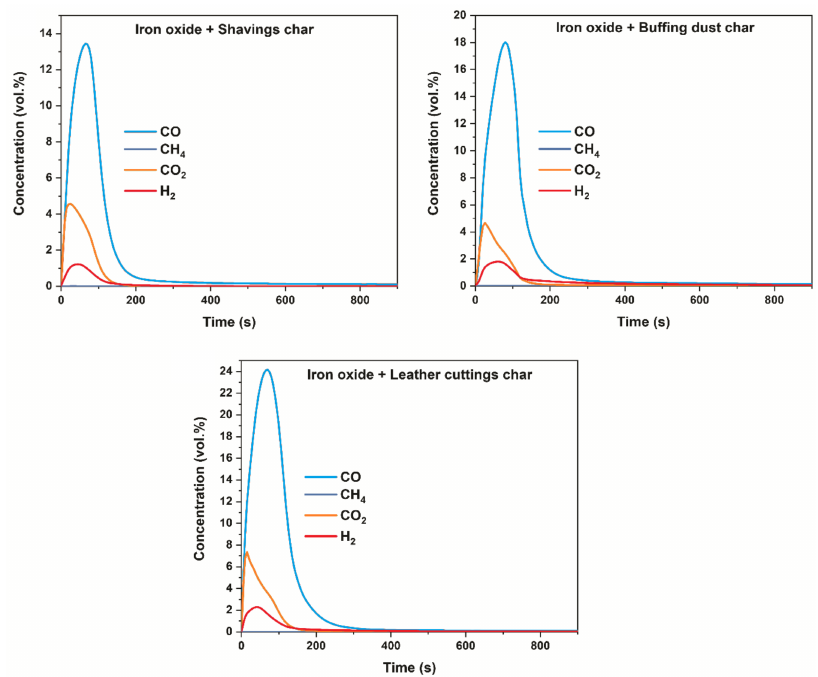
Figure 10. Off-gas produced during the reduction experiments using char produced from leather wastes (Adapted from Nur-A-Tomal, et al. [7]. Reproduced with permission from Springer Nature).